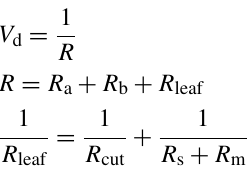
Figure 1. Figure of instrumental setup. Blue lines show the flow of gas that enters the chamber and red lines show the flow of gas sampled from the